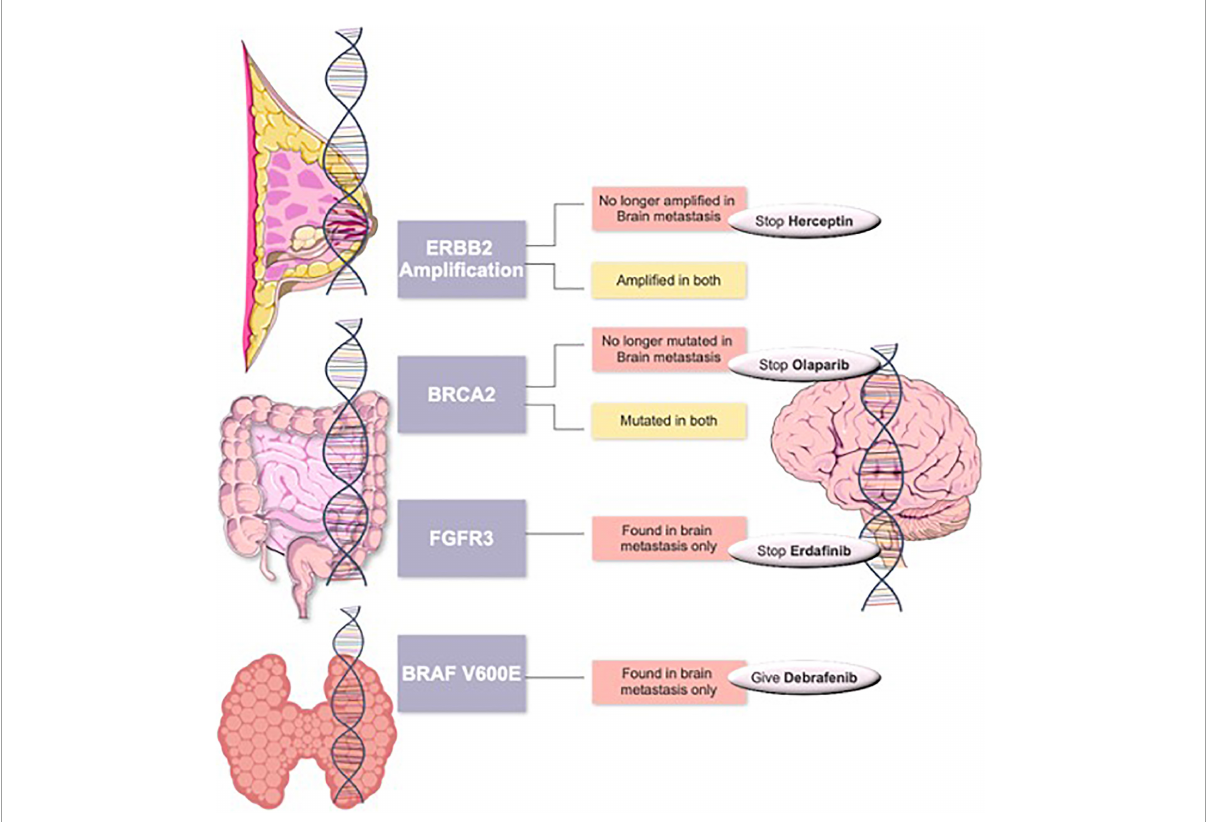
FIGURE4 Suggested targeted therapy scheme in primary tumors such as breast cancer, colorectal cancer or thyroid cancers with changed management in case of changes in their brain metastasis